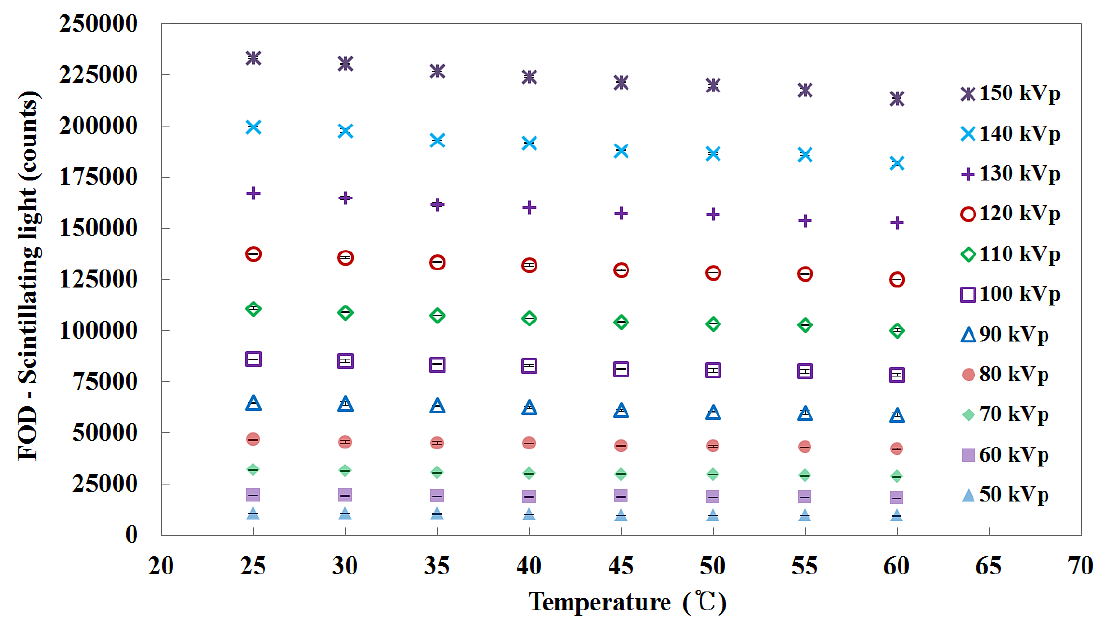
Figure 8. Total counts of the scintillating light signals measured by using the FOD according to the temperature variation of the water at each tube